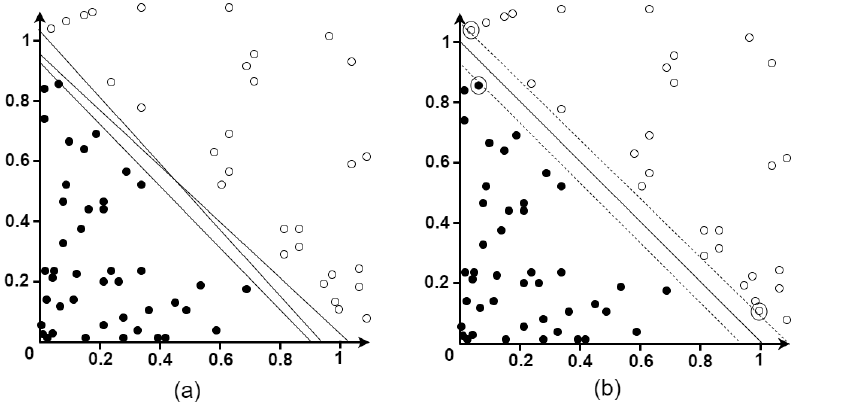
Figure 3. ( a ) Two classes of points. ( b ) maximum margin separator.